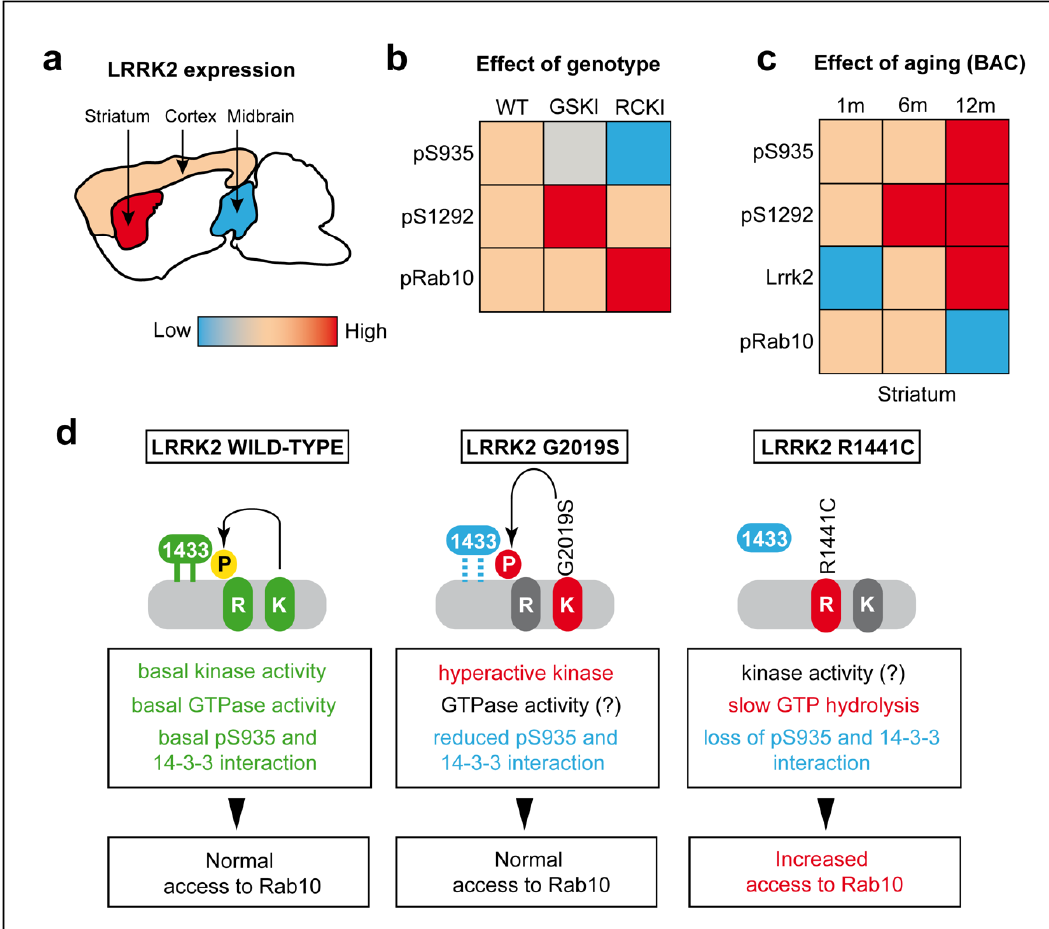
Figure 6. The differential impact of LRRK2 mutations on Rab10 phosphorylation in brain. ( a ) Schematic representation of LRRK2 protein levels in cortex, midbrain, and striatum. ( b ) LRRK2 and Rab10 phosphorylation levels as function of LRRK2 common mutations (G2019S and R1441C) and ( c ) as function of ageing in murine BAC-Lrrk2-G2019S mice. ( d ) Schematic summary of the possible molecular mechanisms underlying the different levels of Rab10 phosphorylation in presence of wild-type or mutated LRRK2. In detail, our data suggest that in the presence of the R1441C-LRRK2 mutation, the reduced phosphorylation at Ser935 may lead to a reduction of LRRK2-14-3-3s binding and thus to an increased access to Rab10.